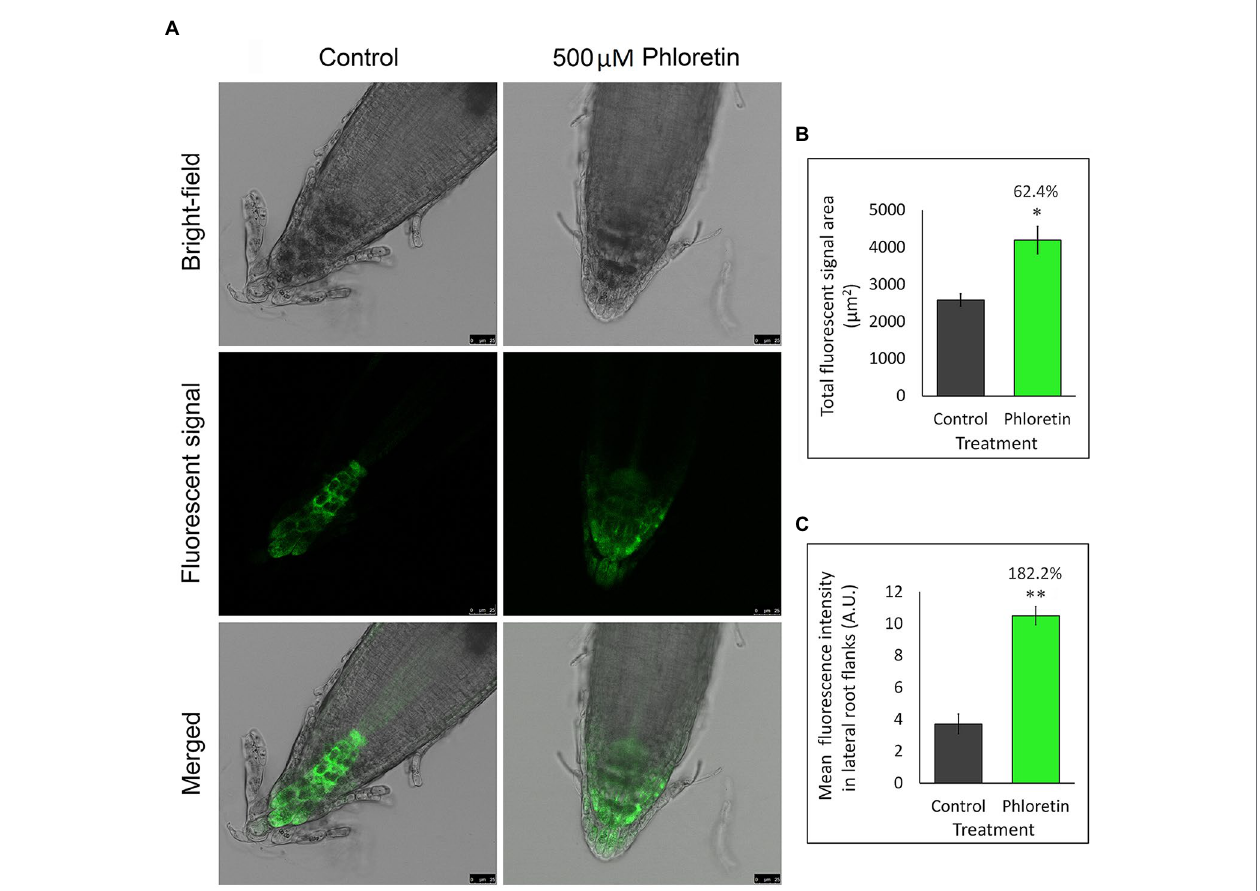
FIGURE 9 | Phloretin significantly alters the distribution of auxin in Arabidopsis root tips. (A) Auxin distribution represented by GFP green fluorescent signal in root tips of 5 days after germination (DAG)-old DR5rev::GFP seedlings vertically grown in Petri dishes with control or 500 μ M phloretin-enriched medium; Bar, 25 μ m. (B) Quantification of the total GFP fluorescent signal area. (C) Mean GFP fluorescent intensity in the lateral flanks of the control and phloretin treated root tips. The lateral flanks are specified as root tip up to quiescent center, excluding the four columns of columella cell in the center of the root tip. Presented data are means ±SE of six seedlings from two independent experiments. Asterisks indicate statistically significant difference at * p < 0.05 and ** p < 0.01 based Student’s t -test, while numbers above the bars indicate the percentage increase of total GFP fluorescent signal area (B) or the mean fluorescence intensity (C) compared to control. Arbitrary units